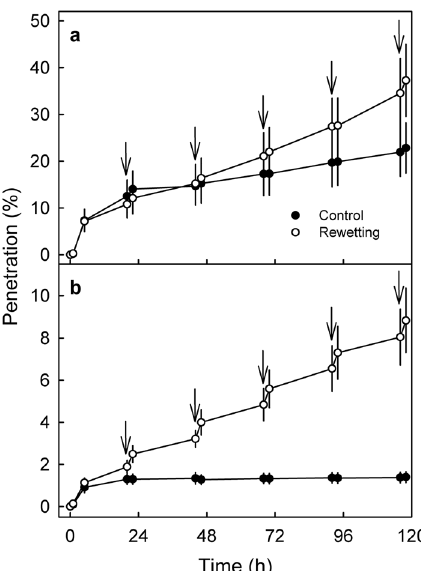
Figure 5. Effect of re-wetting the dried-down droplet deposit on penetration of 45 CaCl 2 ( a ) and 45 Ca-formate ( b ) through excised skin segments of mature sweet cherry fruit. The droplet deposit was re-wetted daily (indicated by arrows) and penetration was monitored at 22 °C and 50% relative